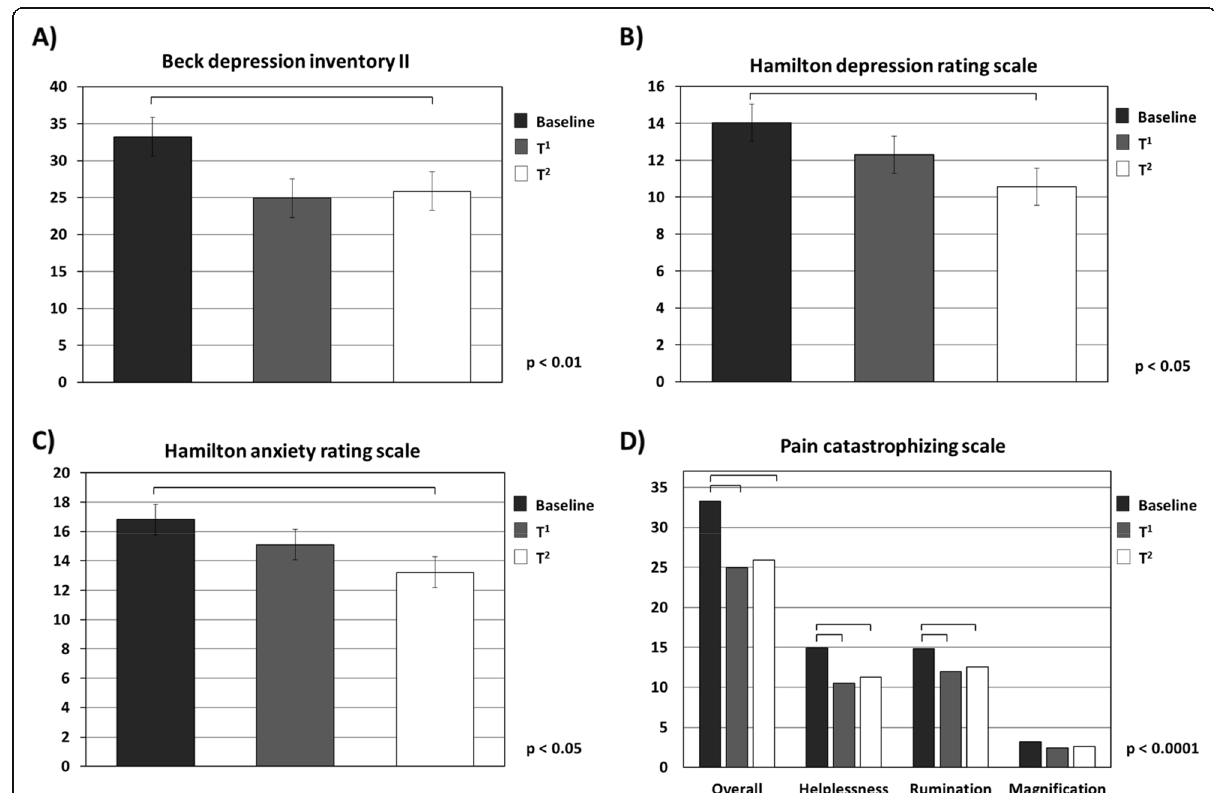
Fig. 4 Depressive and anxiety factors and pain catastrophizing scores at baseline (T 0 ), and at the end of the third (T 1 ) and of the sixth month (T 2 ) of erenumab